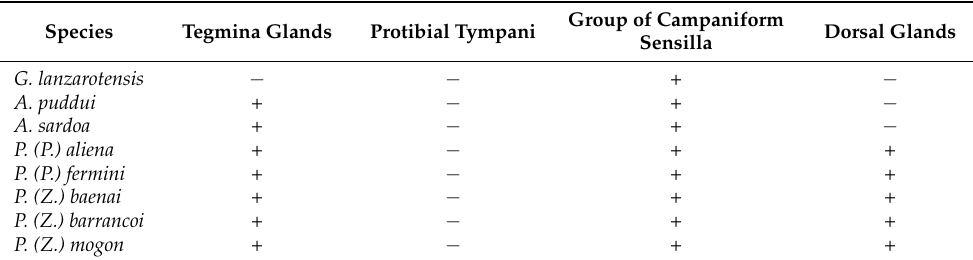
Table 2. Summary of the characteristics presented by each of the eight species analyzed by SEM. The presence (+) or absence ( − ) of certain structures is